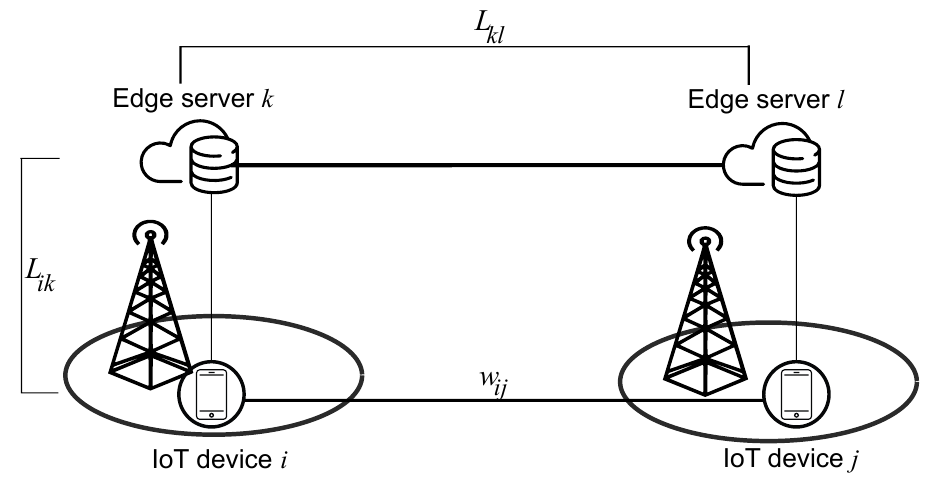
Figure 2. The cost function to be minimized includes the latency between the device and its SDT placed at the edge ( L ik ) and the latency between a couple of friend SDTs placed at edge servers ( L kl